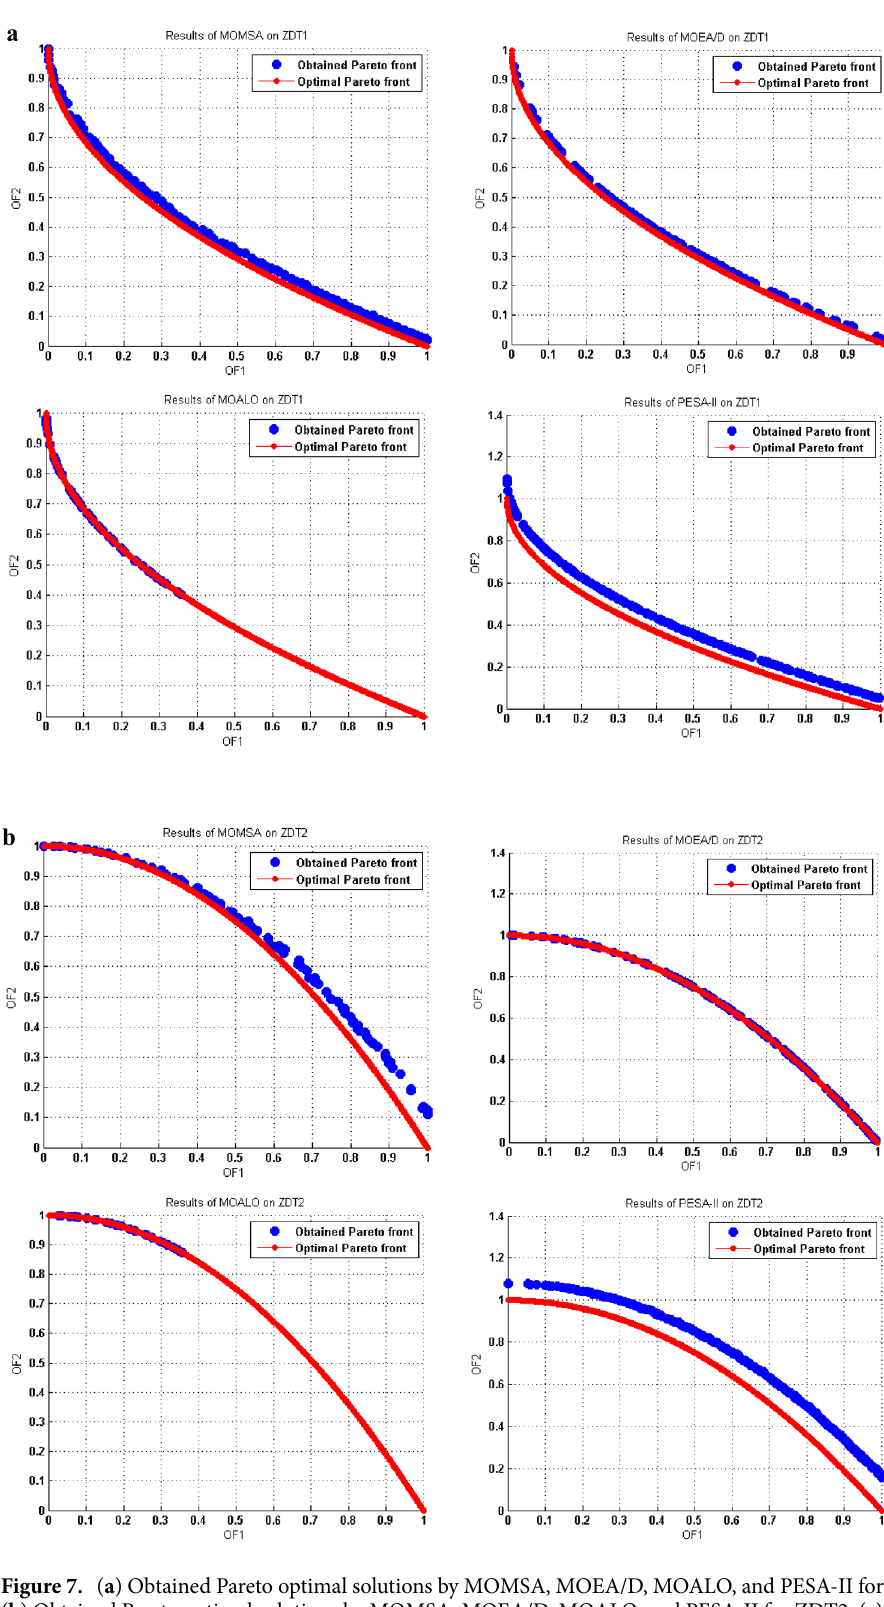
Figure 7. ( a ) Obtained Pareto optimal solutions by MOMSA, MOEA/D, MOALO, and PESA-II for ZDT1. ( b ) Obtained Pareto optimal solutions by MOMSA, MOEA/D, MOALO, and PESA-II for ZDT2. ( c ) Obtained Pareto optimal solutions by MOMSA, MOEA/D, MOALO, and PESA-II for ZDT3. ( d ) Obtained Pareto optimal solutions by MOMSA, MOEA/D, MOALO, and PESA-II for ZDT4. ( e ) Obtained Pareto optimal solutions by MOMSA, MOEA/D, MOALO, and PESA-II for